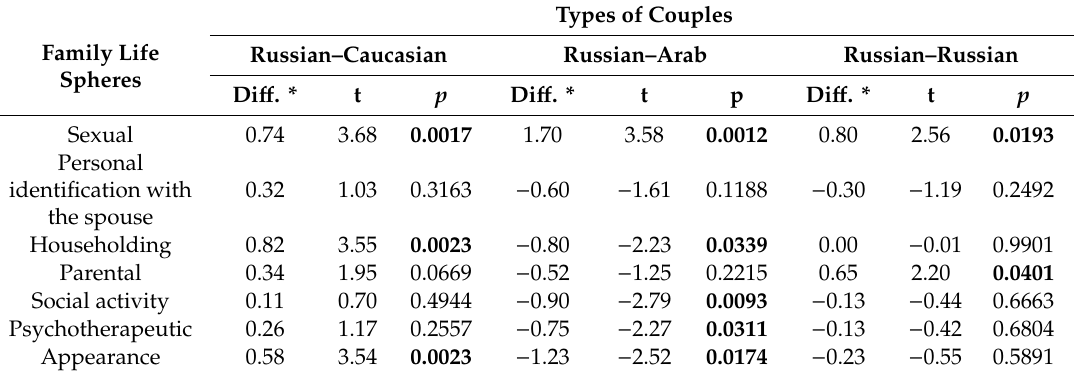
Table 3. The consistency of the spouses’ attitudes about the significance of the family spheres in the couples of di ff erent